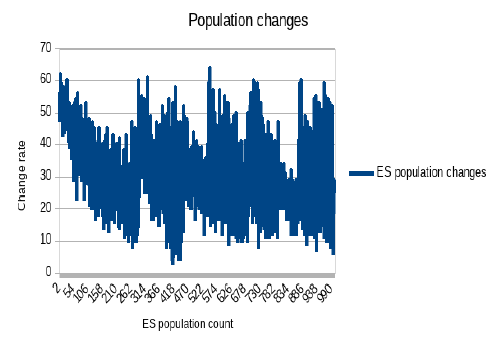
Fig. 1: Count of the ES population improvements for whole GPA population evaluated from the best to the worst